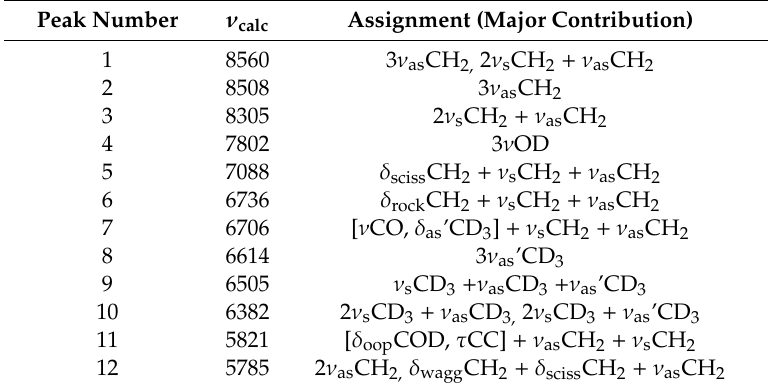
Band assignments in NIR spectra of CD 3 CH 2 OD based on GVPT2 // B2PLYP-GD3BJ / def2-TZVP // CPCM calculations. Band numbering corresponds to that presented Figure